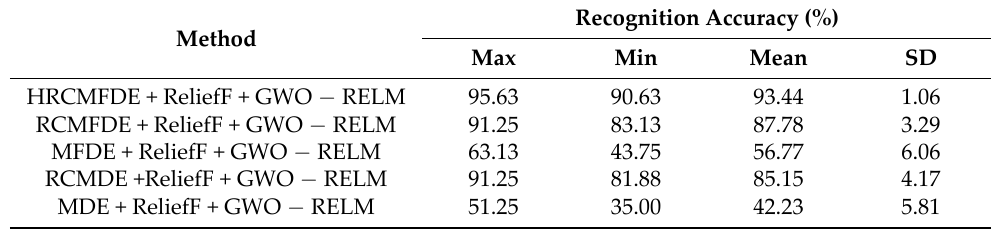
Table 4. The performance comparison between different methods without ReliefF.